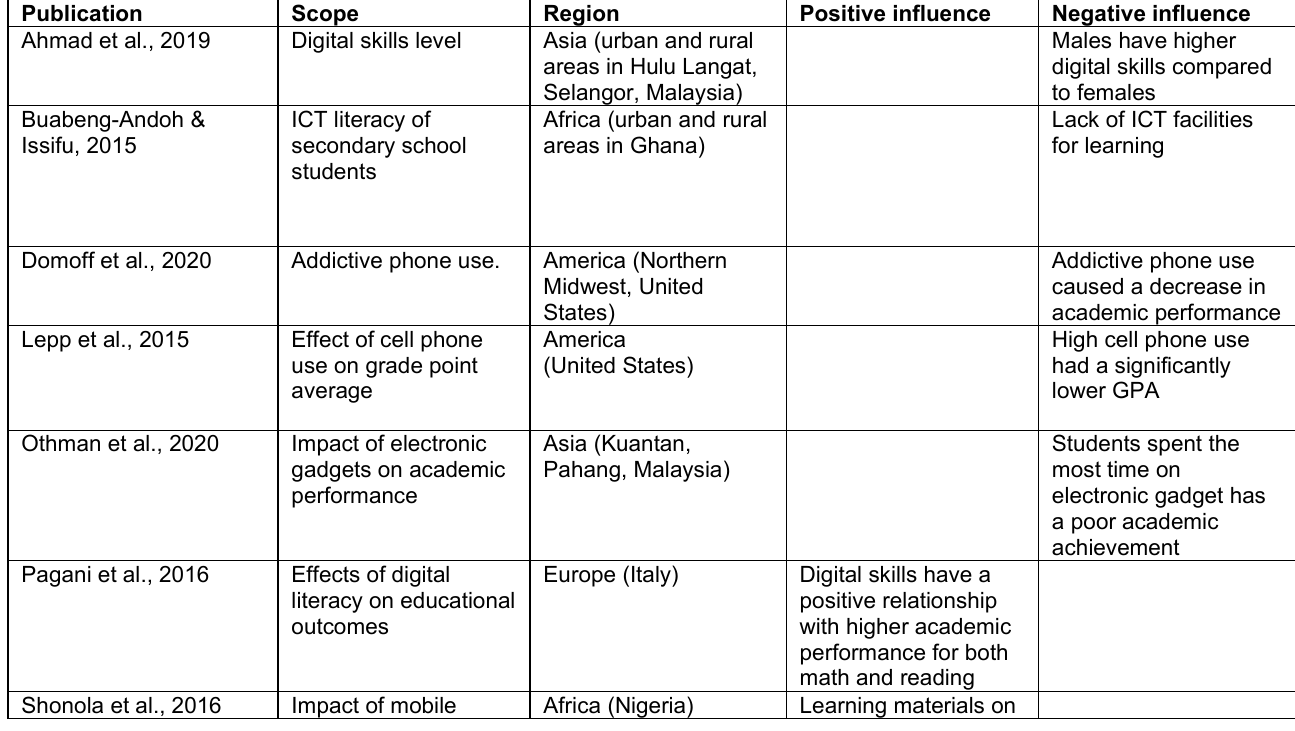
Table 2. Studies on the influence of ICT on